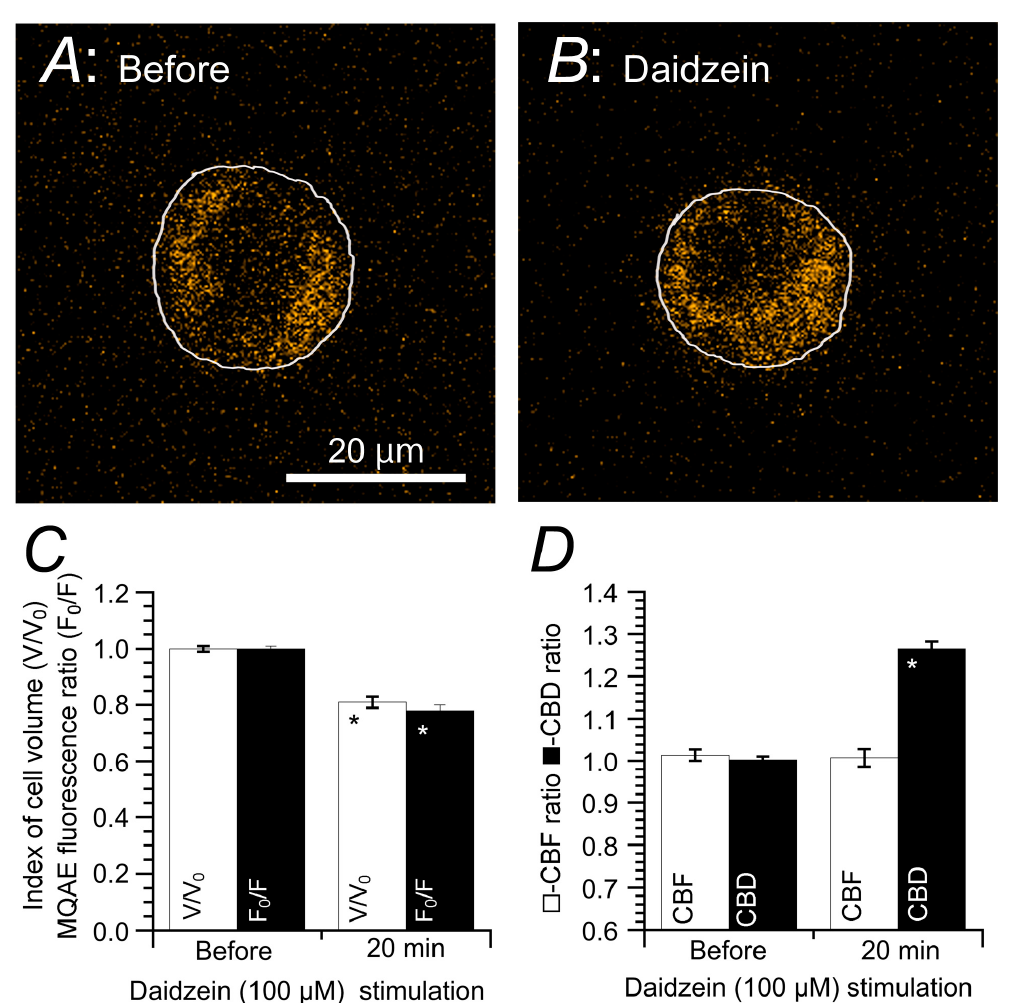
Figure 4. Changes in [Cl − ] i and cell volume following daidzein stimulation. Prior to daidzein (100 µM) stimulation, ciliated human nasal epithelial cells (cHNECs) were first perfused with a CO 2 /HCO 3 − -containing control solution for 5 min, followed by a CO 2 /HCO 3 − -free control solution for another 5 min. Then, a cell outline was superimposed on the N-ethoxycarbonylmethyl-6-methoxyquinolinium bromide (MQAE) fluorescence. ( A ) The MQAE fluorescent image of a cHNEC immediately prior to daidzein stimulation. ( B ) The MQAE fluorescent image of a cHNEC 20 min after daidzein stimulation (100 µM). Daidzein stimulation decreased cell volume and enhanced MQAE fluorescence intensity, indicating that daidzein decreased [Cl − ] i coupled with cell shrinkage. ( C ) Changes in MQAE fluorescence and cell volume. Daidzein decreased cell volume (V/V 0 ), leading to decreased [Cl − ] i . ( D ) Changes in CBF and CBD during daidzein stimulation. Daidzein stimulation increased CBD but not CBF. * indicates results significantly different from the control values ( p < 0.05). Error bars indicate SE. This figure was modified from Inui et al., 2018 [16] with permission.